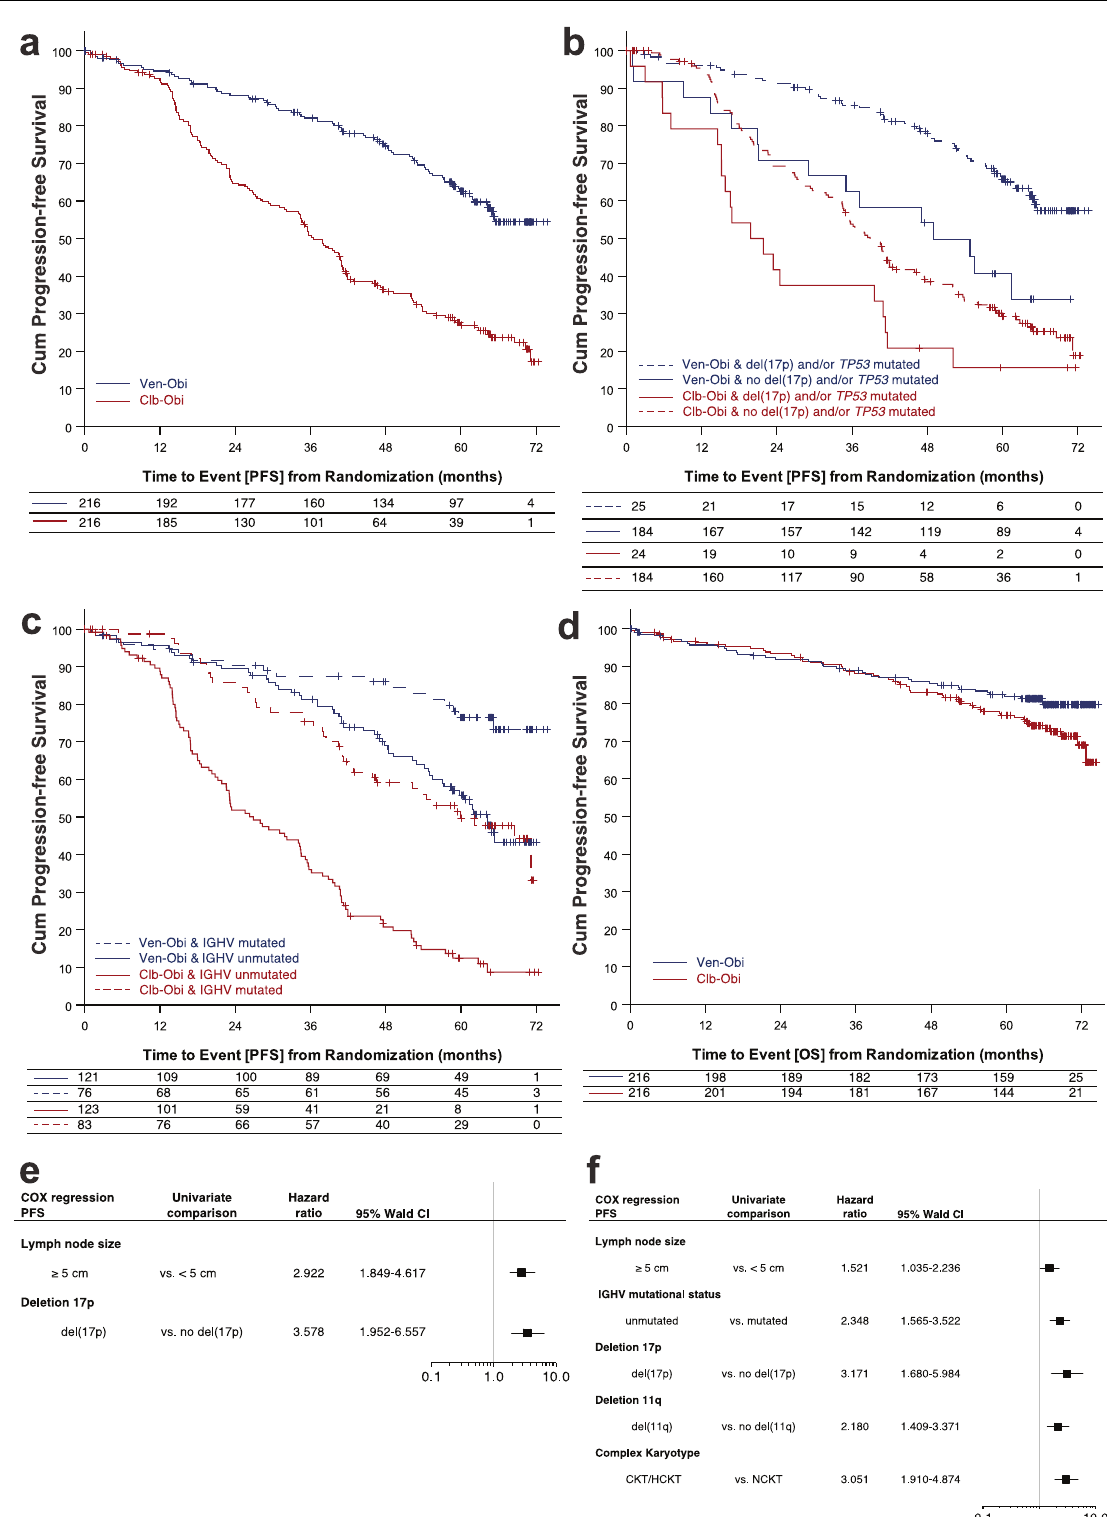
Fig. 1 | Progression-free survival (PFS) and overall survival (OS) analyses. a PFS according to study arm, b PFS according to TP53 status, c PFS according to IGHV mutational status, d OS according to study arm, e multivariable analyses of PFS in